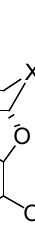
Figure 12. Morphine agonist Oximorphone and antagonist Nalox- one. Oximorphone (X = CO, R = CH 3 ) agonist. Naloxone (X = CO, R = CH 2 -CH=CH 2 ) antagonist used in opiates